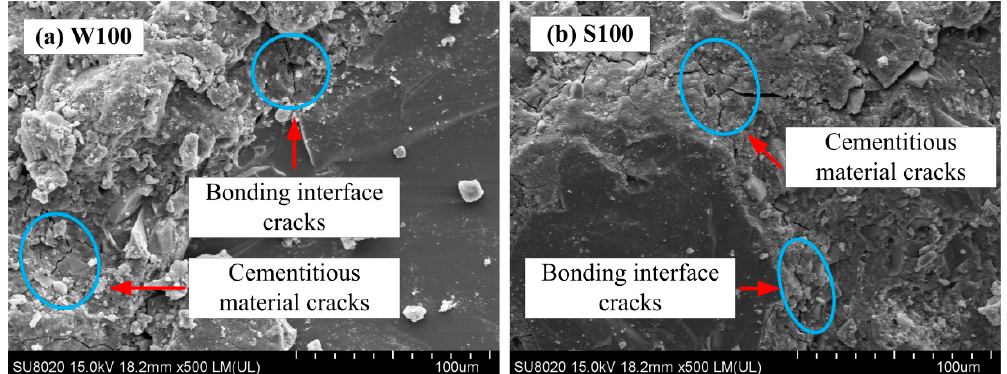
Figure 14. SEM image of ACSC freeze-thaw cycles of ( a ) W100 and ( b )